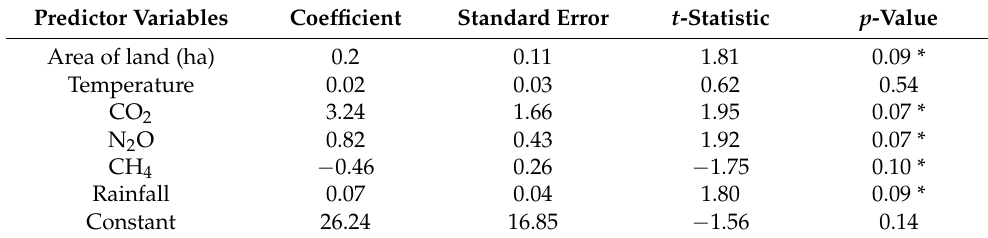
Table 3. Long-run (LR) estimate of cassava